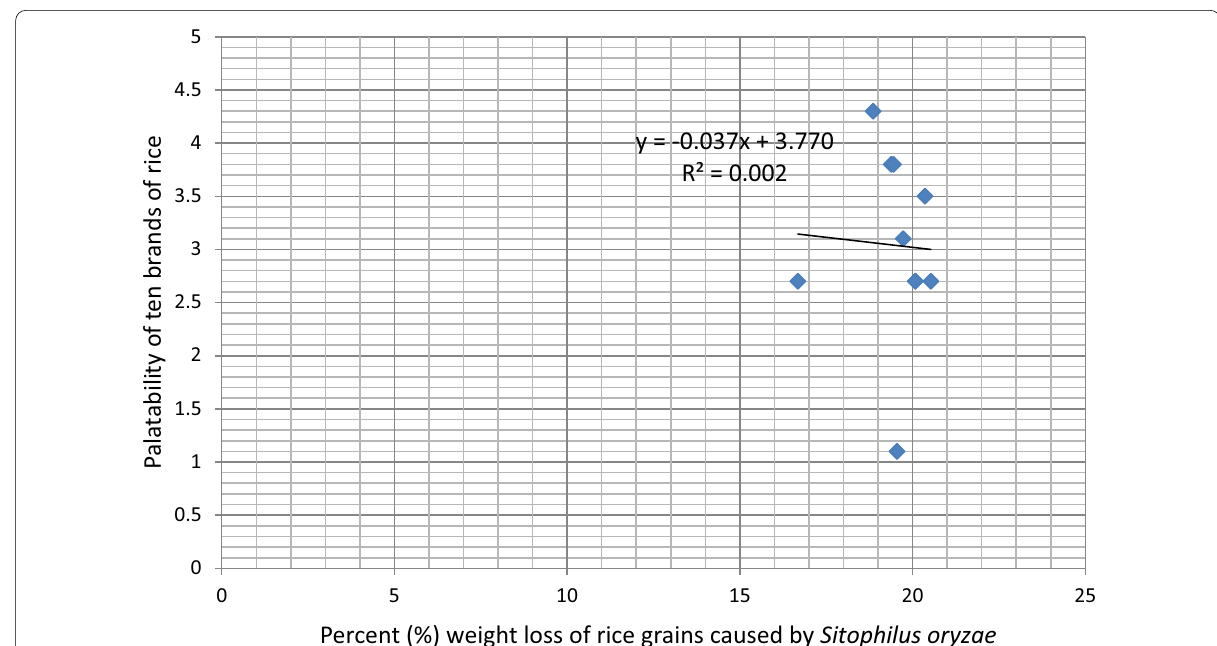
Fig. 2 Association between rice brand palatability and grain weight loss caused by Sitophilus oryzae